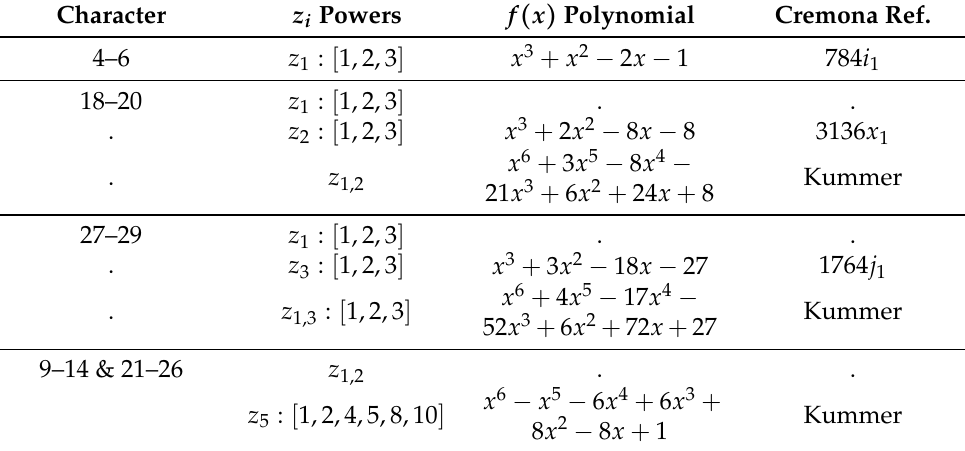
Table 3. The algebra for the character table of group G 7 : = ( 336,118 ) . In column 1 are the characters in question. Column 2 provides the powers of the entries z i , i = 1, 2, 3 or 5. The z i are z 1 = 2cos ( 2 π /7 )